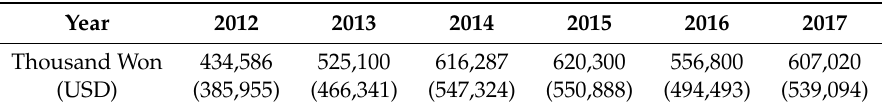
Table 7. Financial Support for the Monastic